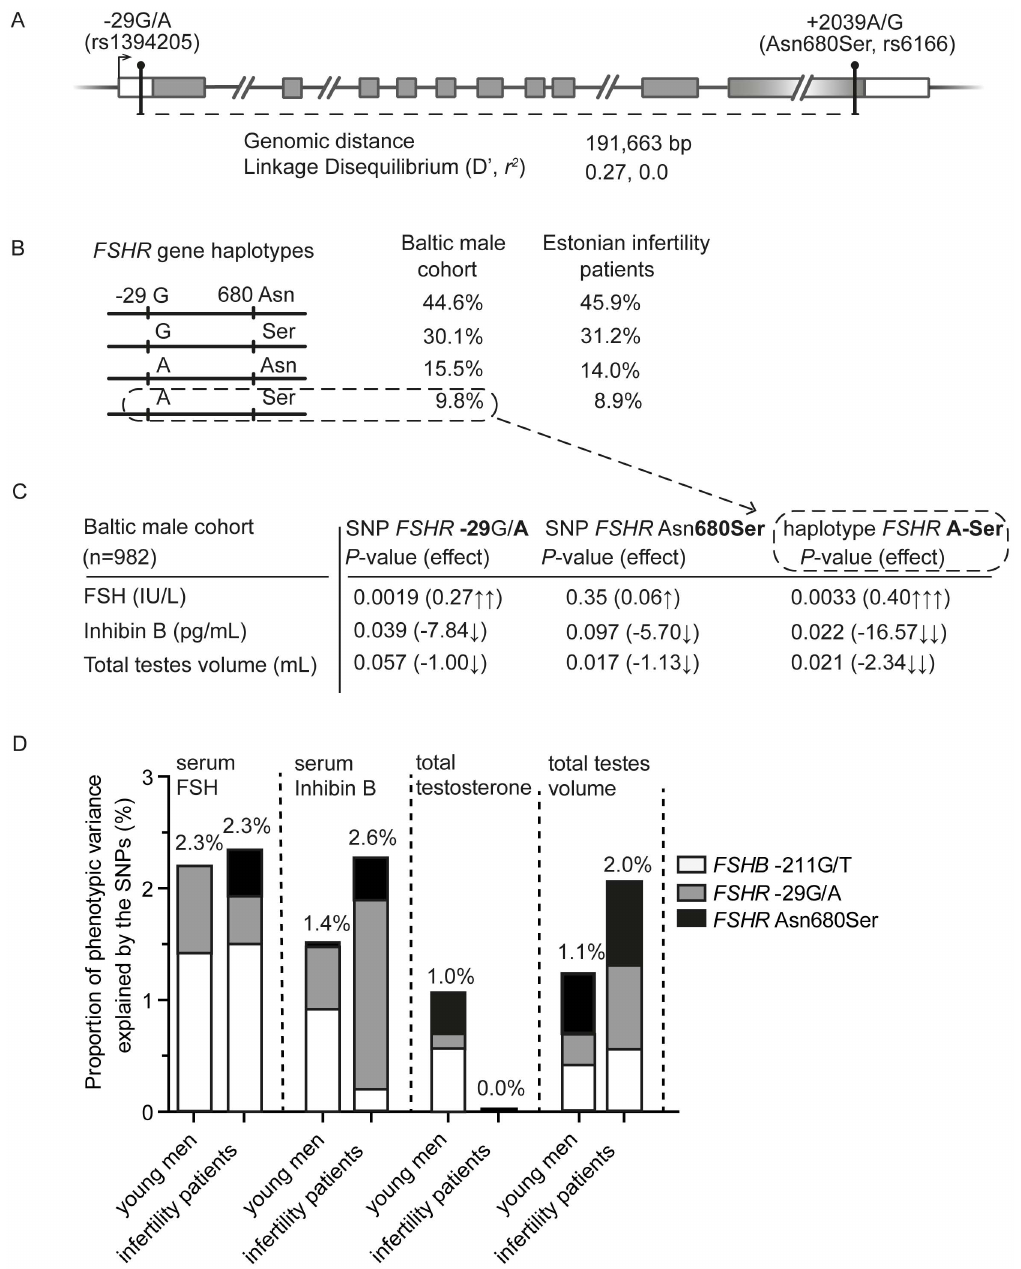
Figure 1. Genomic structure of the FSHR and effect of the FSH-action modulating genetic variants on reproductive parameters. A , Schematic representation of the structure of the FSHR gene drawn to an approximate scale. Exons are depicted as boxes, translated sequences are shaded in grey and transcription start-site is denoted with up-right arrow. Circle-headed bars indicate the location of FSHR SNPs -29G/A and + 2039A/ G (Asn680Ser); and their mutual genomic distance and linkage disequilibrium is provided. B , Distribution of the four FSHR haplotypes (G-Asn, G-Ser, A-Asn, A-Ser) formed from the FSHR -29G/A and + 2039A/G (p.Asn680Ser) variants in the Baltic male cohort and Estonian oligozoospermic infertility patients (number of phased chromosomes, n=1964 and n=1282, respectively). C , Individual allelic effects of the FSHR -29 A-allele and FSHR 680Ser (c. + 2039 G), and the cumulative haplotypic effect of the formed FSHR A-Ser gene variant on serum FSH, Inhibin B and total testes volume in the Baltic young men cohort. Results of the association testing are presented as P -values and effect sizes (regression coefficient, b ) from linear regression analysis. Arrows indicate the strength and direction of the effects. D , Proportion of total phenotypic variance (%) of serum FSH, Inhibin B, total testosterone and total testes volume explained by the FSHB -211G/T (white bars), FSHR -29G/A (grey bars) and FSHR Asn680Ser (black bars) genetic variants in the Baltic young male cohort. Individual and cumulative effects of the SNPs were estimated by using the REML analysis implemented in GCTA software [33].